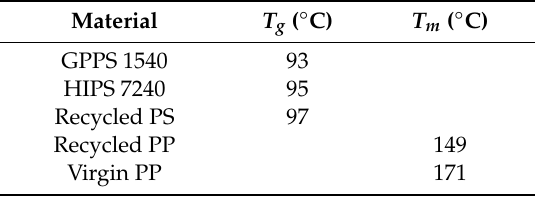
Table 1. Summary of the temperatures of glass transition and melting temperatures determined